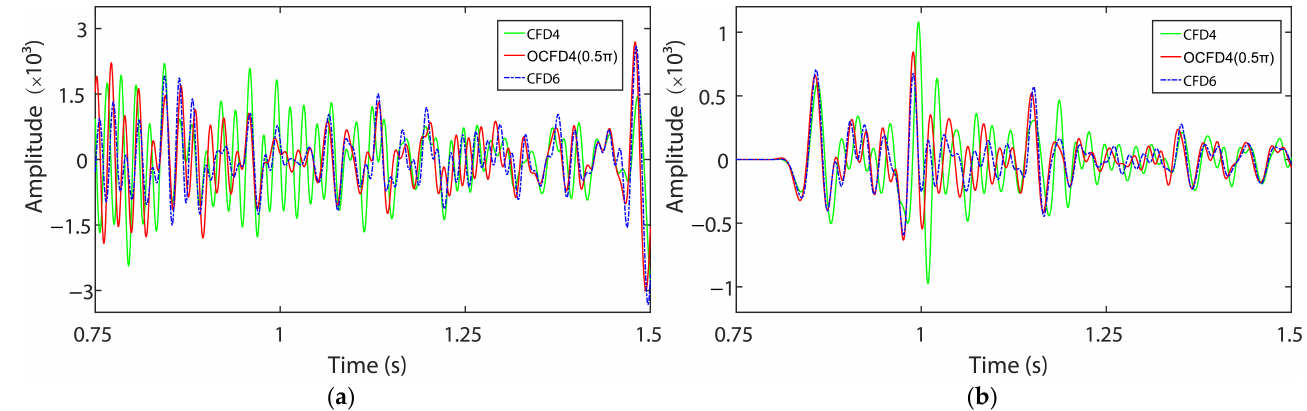
Figure 10. Single traces exacted from the shot records in Figure 9 at the distance of ( a ) 1.5 km and ( b ) 3.75 km.